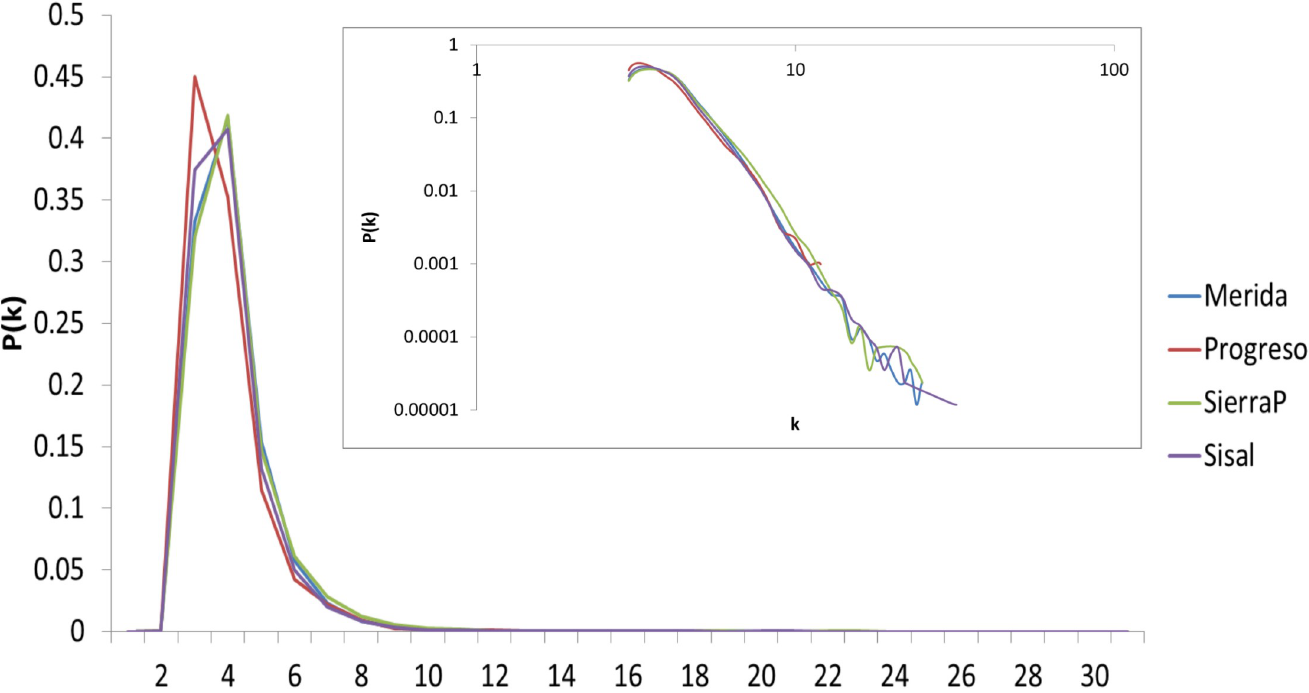
Fig 4. Degree distribution of networks generated with HVA. The degree distributions in normal scales and in logarithmic scales in the inset. None of the visual representations shown display any pattern that allows us to qualitatively determine any insights, as observed in the degree distributions generated by NVA.